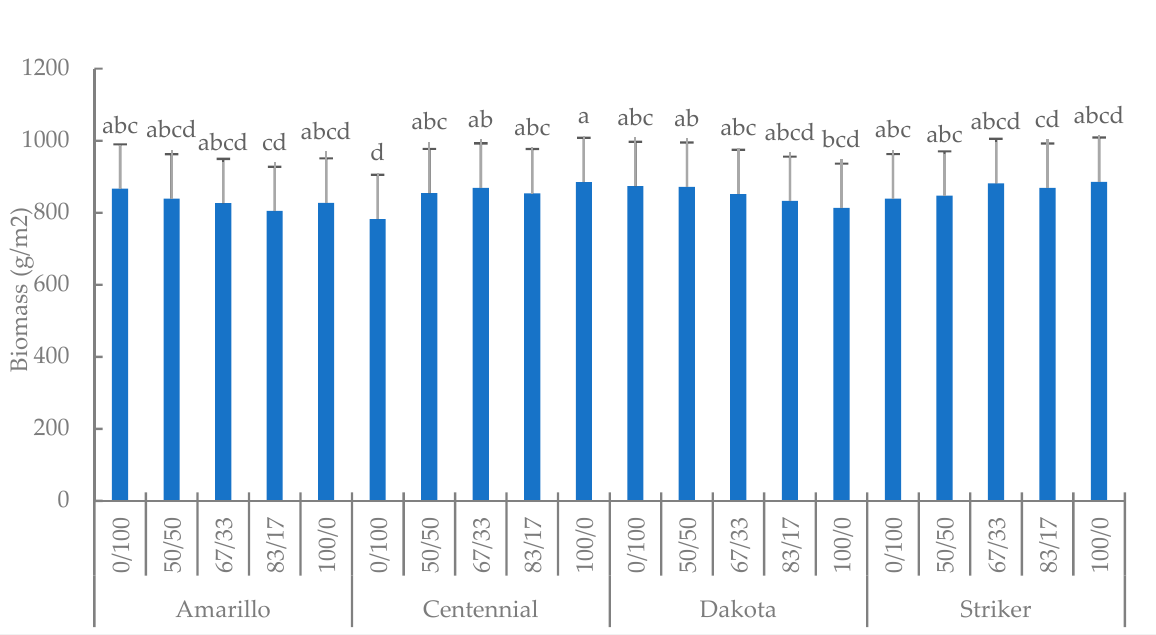
Figure 6. Interaction of variety and leaf-type mixing ratio on field pea biomass. Mean of six site-years, one in 2017, two in 2018, and three in 2019. Columns with different letters (a–d) represents that the mean biomasses were significantly different in LSD 0.05 . The error bar represents the positive standard error in LSD 0.05 . Treatments were listed as semi-leafless + leafed pea, 0/100 is leafed monoculture, for CDC Amarillo (Amarillo), CDC Centennial (Centennial), CDC Dakota (Dakota), and CDC Striker (Striker).